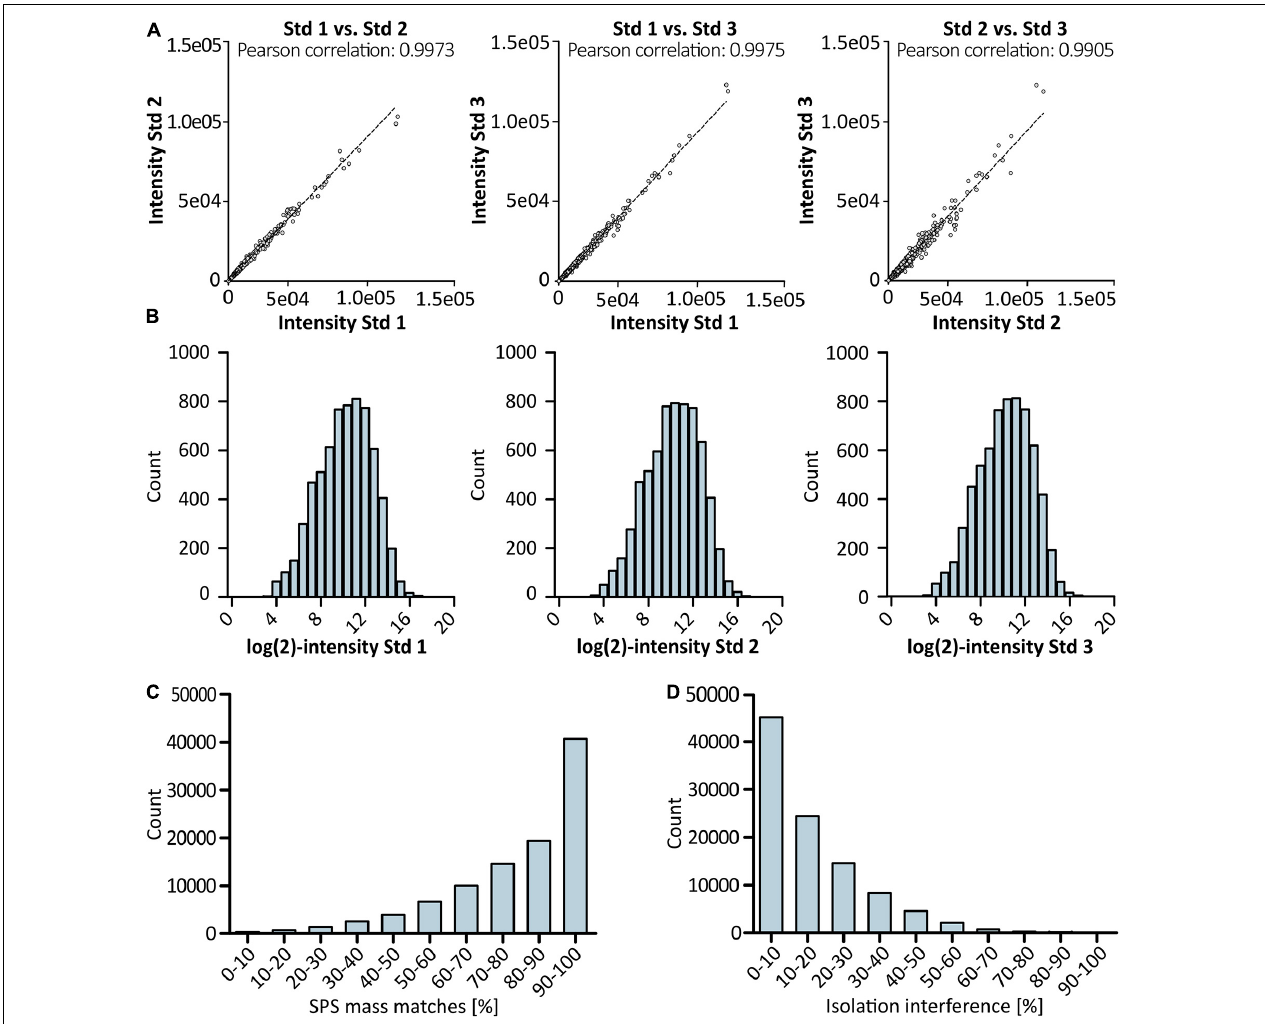
FIGURE 3 | Results of proteomic profiling using LC/LC-SPS-MS 3 . Scatter plots in (A) show Pearson correlation between biological replicates derived from cells grown under standard conditions ( n = 3). TMT reporter intensity values were log-transformed and plotted in a histogram (B) to show distribution of quantification values for control samples. Accuracy of quantification was evaluated by checking SPS match accuracy (C) and precursor ion co-isolation (D) in% of PSMs using Thermo Scientific’s Proteome Discoverer software. For each sample, two technical replicates were